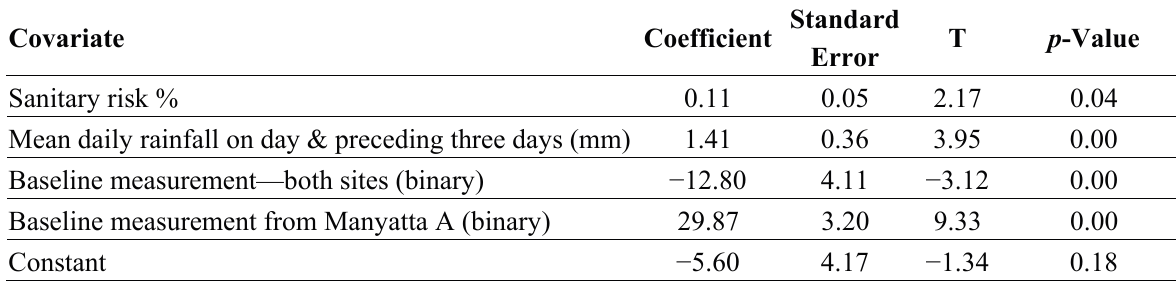
Table 3. Linear regression results, showing risk factors for nitrate contamination of hand-dug wells at baseline (2004) and in 2014 (n = 58, adjusted R 2 = 0.78).